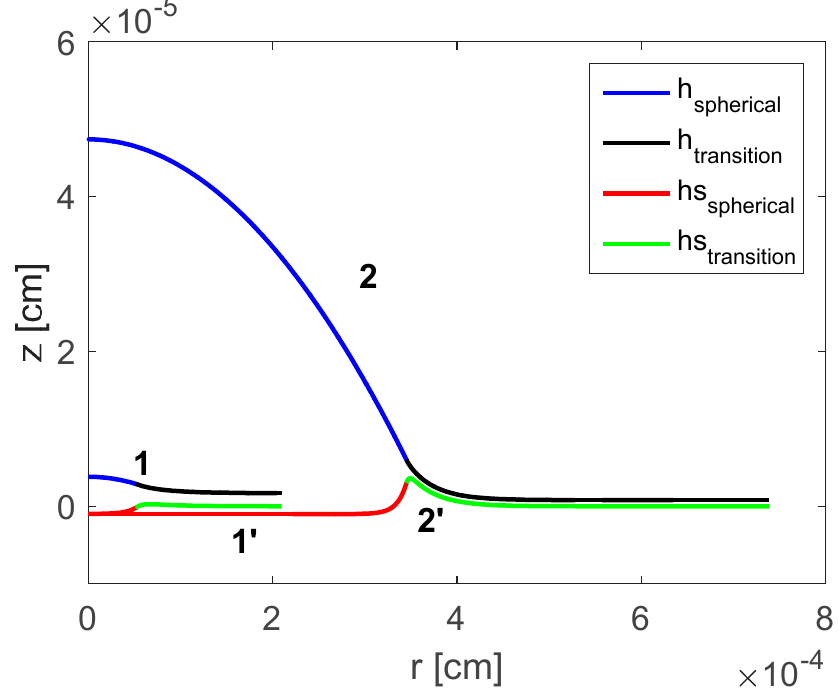
Figure 4. Computed shapes of the droplet and deformation of the substrate: 1,1 (cid:48) − a = 1 × 10 11 dyne/cm 3 Figure 4 . Computed shapes of the droplet and deformation of the substrate: 1, 1 (cid:4593) − 𝑎 = 1 × 10 (cid:2869)(cid:2869) and 2,2 (cid:48) − a = 1 × 10 12 dyne/cm 3 [18]. Reproduced with permission from [18]. Copyright © 2017 dyne/cm 3 and 2,2 (cid:4593) − 𝑎 = 1 × 10 (cid:2869)(cid:2870) dyne/cm 3 [18]. Reproduced with permission from [18]. Copyright Elsevier © 2017 Elsevier B.V.